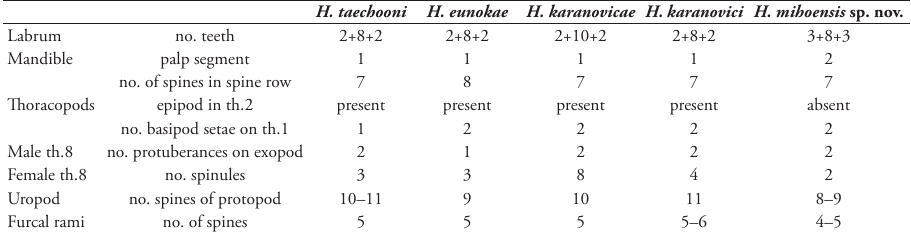
Table 1. Morphological differences among the five species of Hangangbathynella . Abbreviation: th. =